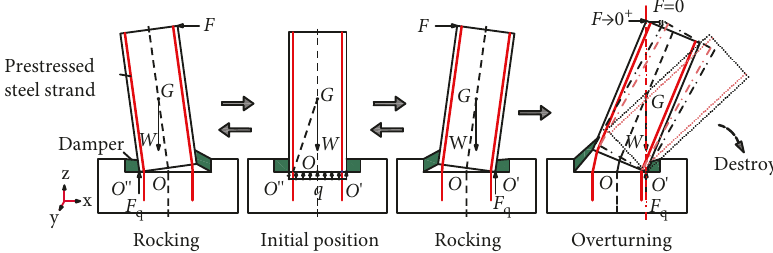
Figure 2: The schematics of the rocking process for the